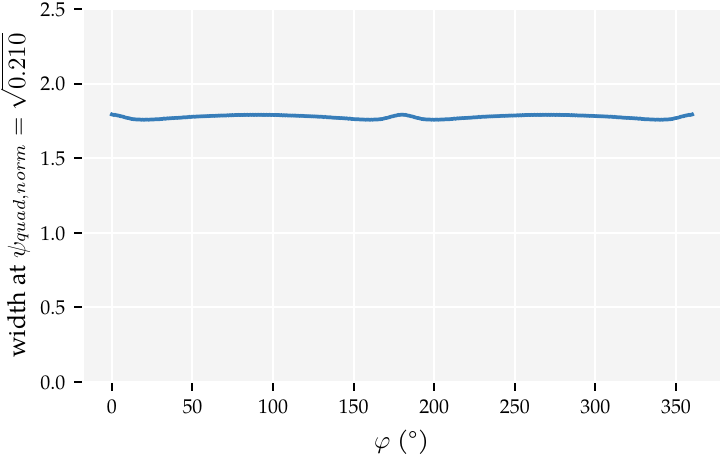
Figure A3. The width between the secondary anchor points ± ρ anch of the normalised quadrature curve ψ quad , norm are almost constant 1.78 ± 0.011 with respect to the movement direction angle ϕ and √ is well approximated by the analytically determined value 4/